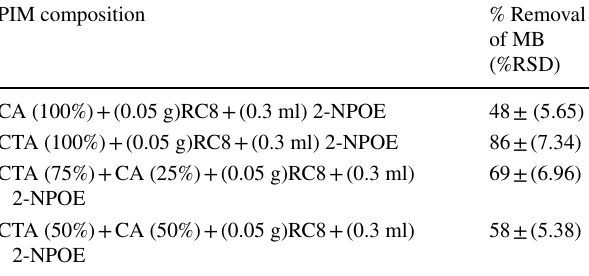
Table 3 Effect of the base polymers in MB